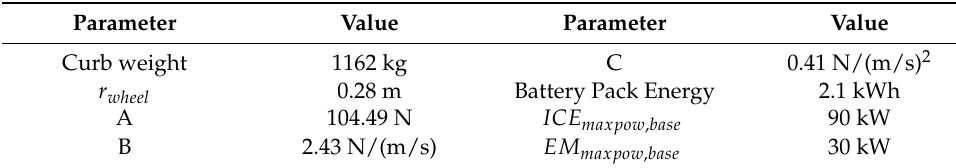
Figure 1. Parallel P2 full hybrid electric vehicle (HEV) architecture. Table 1. Hybrid electric vehicle (HEV)